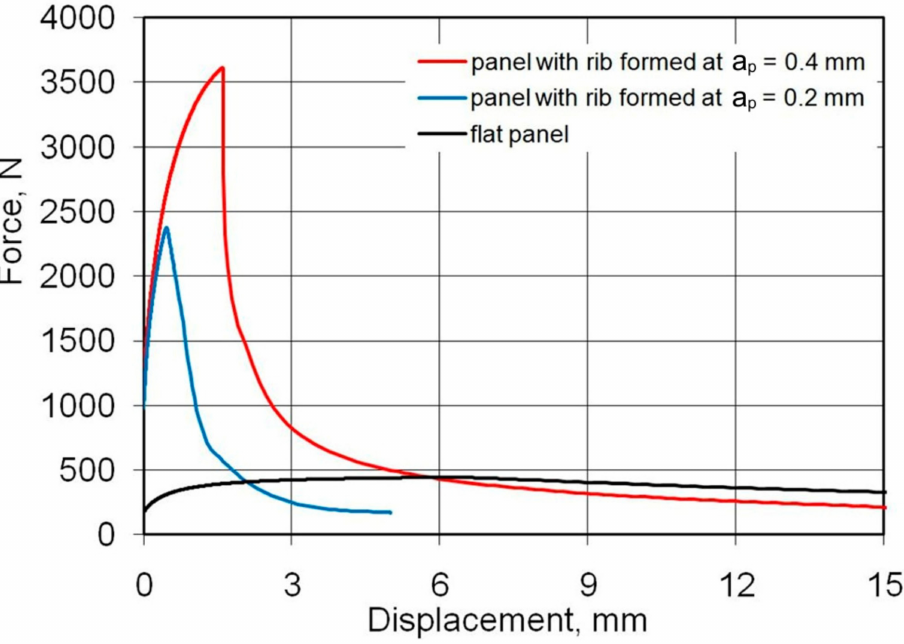
Figure 9. Load-displacement curves of the panels fabricated from 0.4-mm-thick EN AW-2024-T3 Alclad panels subjected to compression